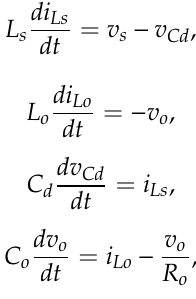
Figure 6. Equivalent circuit of the bridgeless Cuk converter in State 2 during positive half line cycle.